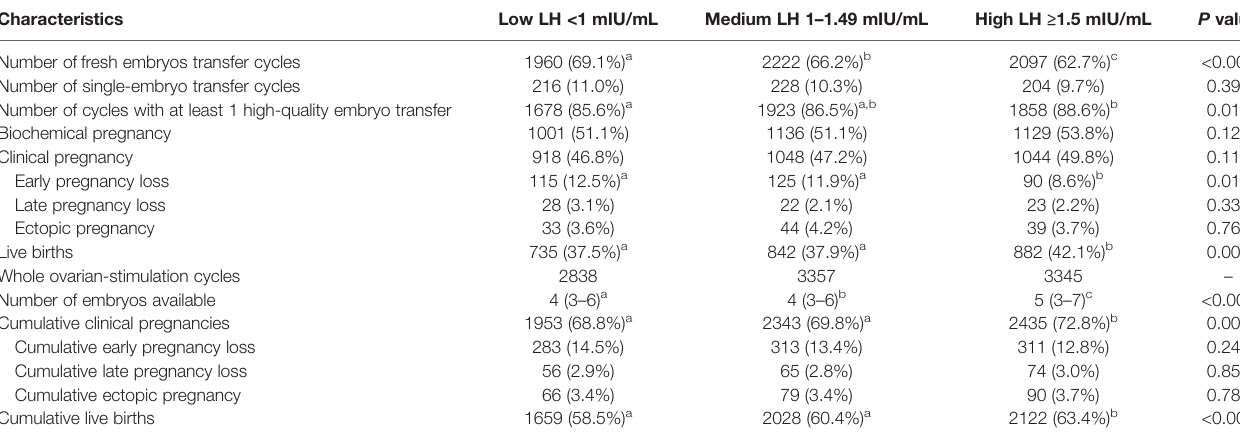
TABLE 2 | Clinical outcomes of LH groups on COS initiation day.